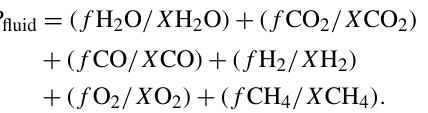
(dashed lines in Fig. 1) that connects the graphite